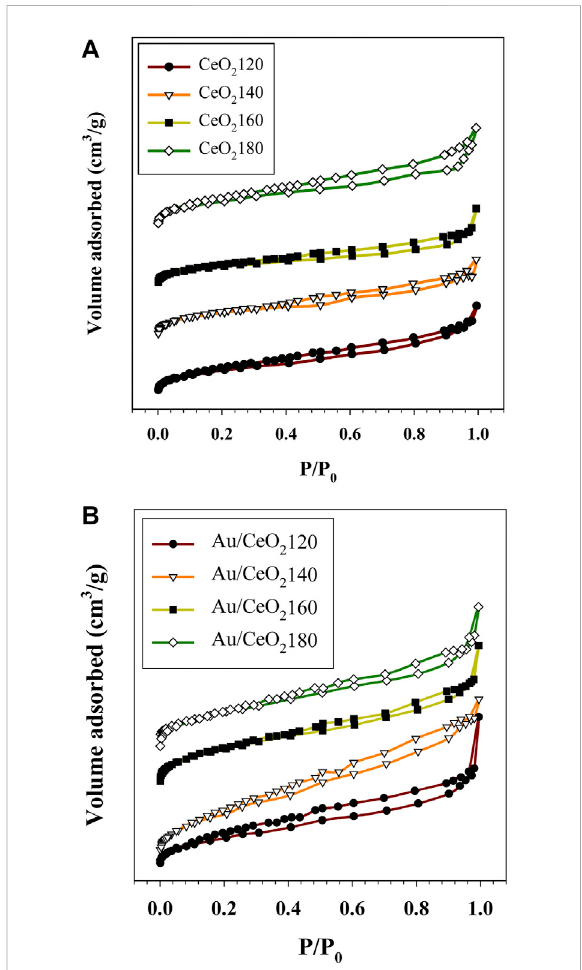
FIGURE 3 Representative N 2 adsorption – desorption isotherms of (A) the synthesized CeO 2 X supports and (B) the prepared Au/CeO 2 X catalysts. The reported isotherms are representative of those obtained from two independent samples. CeO 2 X: cerium oxide obtained at a value X for the temperature of the preparatory hydrothermal process; Au/CeO 2 X: CeO 2 X-supported gold